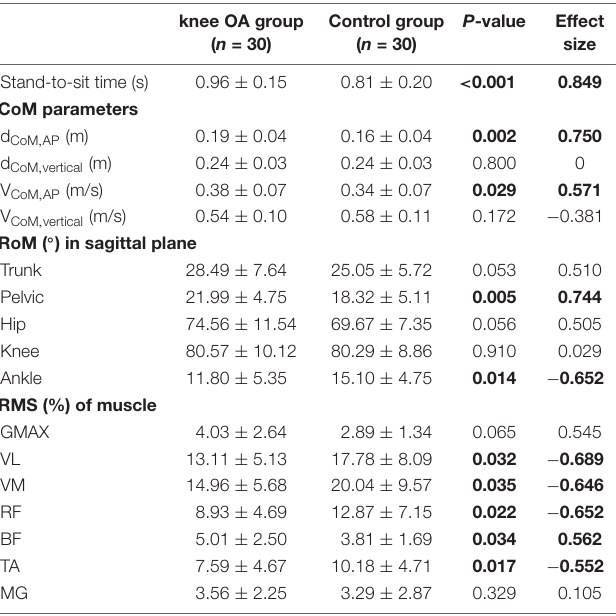
TABLE 3 | Data between the knee OA and control groups.